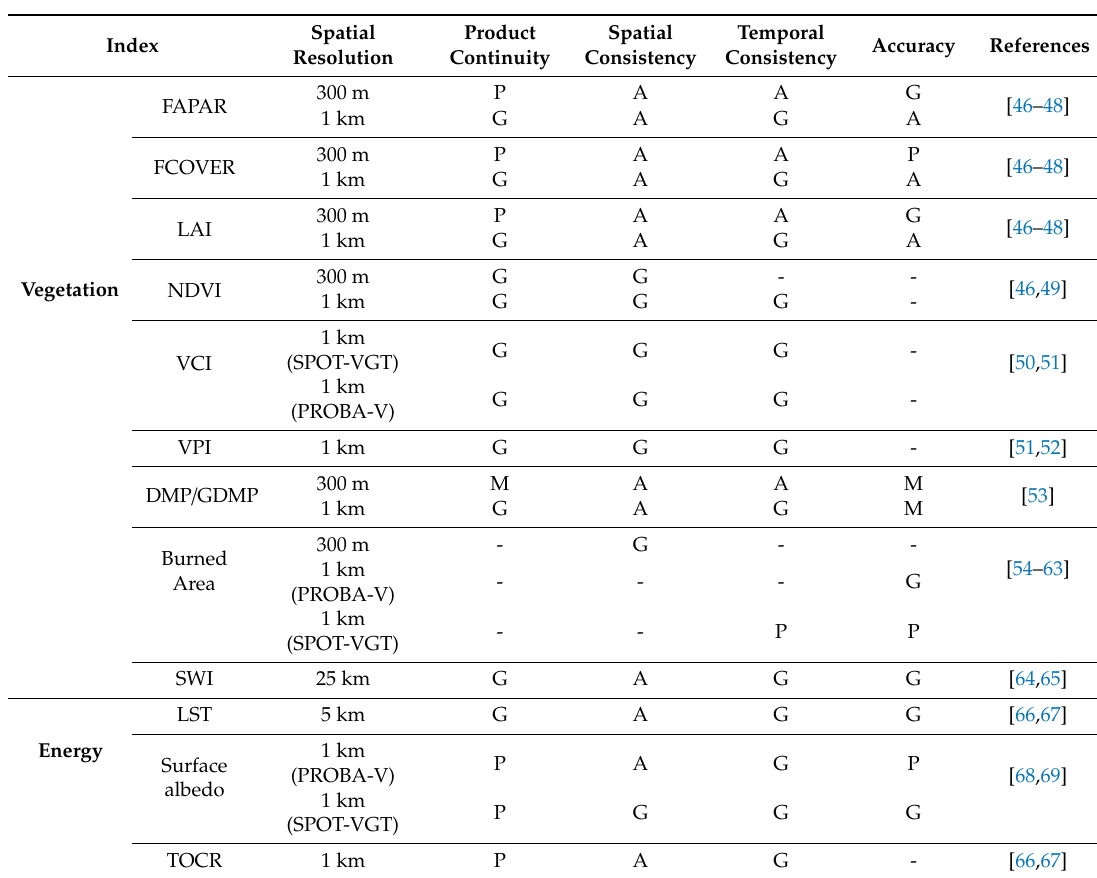
Table 4. Quality and accuracy assessments of the bio-geophysical indices provided by the Copernicus Global Land Service (CGLS) vegetation and energy products, evaluating the product continuity, spatial consistency, temporal consistency, and accuracy as either good (G), acceptable (A), moderate (M), or poor (P) as in the consulted references [40] (as of November